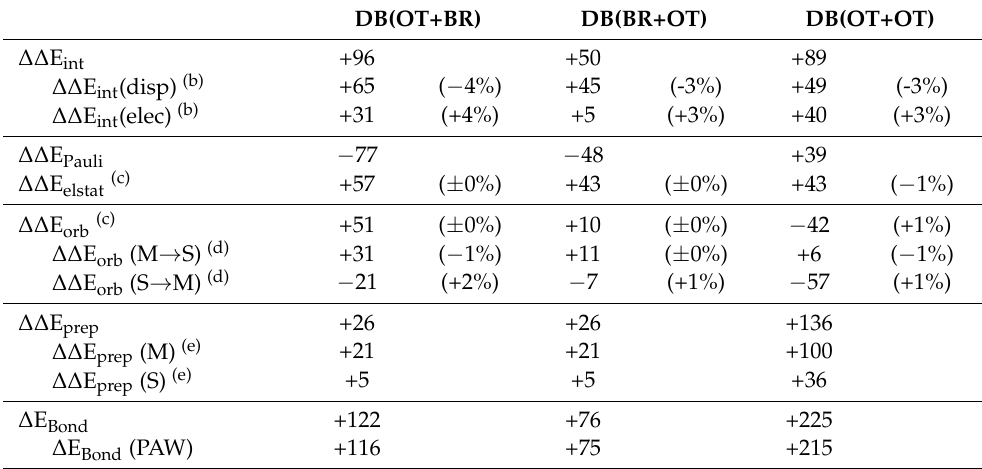
Table 2. Bonding analysis (pEDA) for the doubly bonded structure motifs (a) . In this table, the difference between the sums of the two parent structures is shown. The absolute values are presented in Table